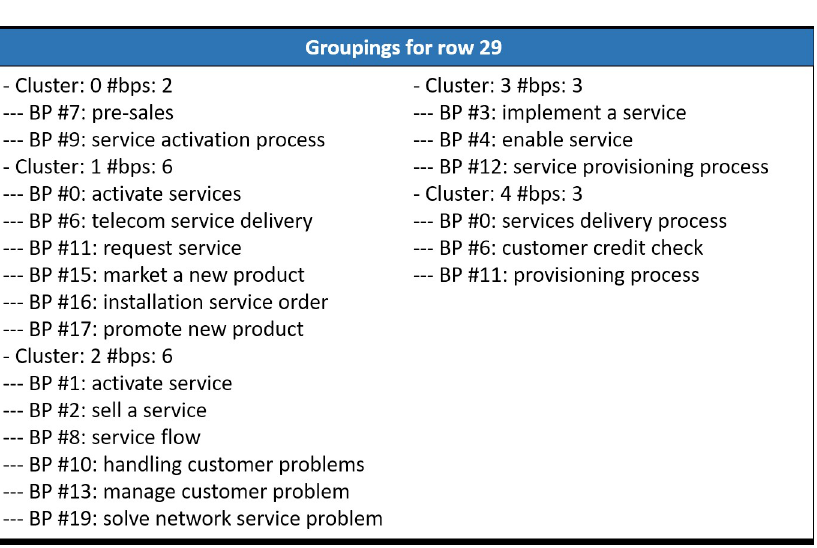
Fig 11. Groupings created using